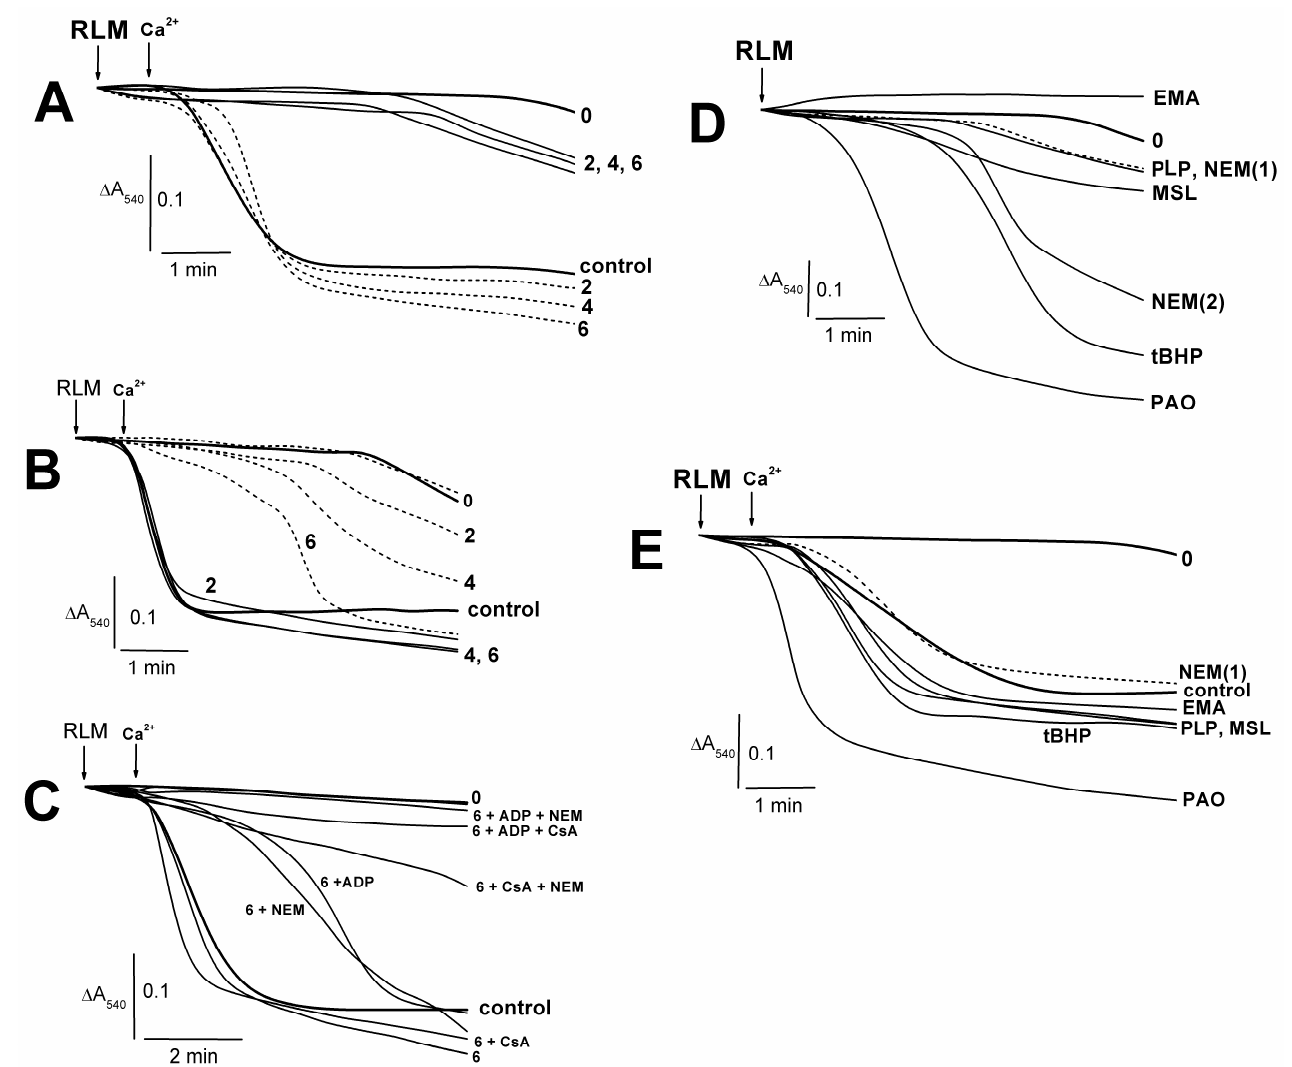
Figure 1. Effects of Ca 2+ , pyridoxal 5-phosphate, and thiol reagents on the Tl + -induced swelling of succinate-energized rat liver mitochondria. Mitochondria (1.5 mg of protein per mL) were injected into the medium containing 75 mM TlNO 3 , 125 mM KNO 3 , 100 μM Ca 2+ (where indicated), and 5 mM Tris-succinate (pH 7.3). In addition, the medium was supplemented with 500 μM ADP (( B ) short dash traces). The following reagents were added into the medium before mitochondria (( C – E ), indicated to the right of traces) 500 μM ADP (ADP), 1 μM CsA (CsA), 50 μM NEM (NEM(1)), 500 μM NEM (NEM(2)), 10 μM EMA (EMA), 20 μM MSL (MSL), 6 mM PLP (PLP), 100 μM t BHP ( t BHP), and 5 μM PAO (PAO). Additions of mitochondria (RLM) and 100 μM Ca 2+ (Ca 2+ ) are shown by arrows. Experiments free of Ca 2+ (solid traces) or ones with 100 μM Ca 2+ (short dash traces) showed on panel A . The numbers to the right of the traces ( A – C ) show concentrations (μM) of PLP, which was added into the medium before mitochondria. The bold traces show experiments free of Ca 2+ and PLP (0) or ones with Ca 2+ alone (control). Representative traces from one of three independent experiments are presented.